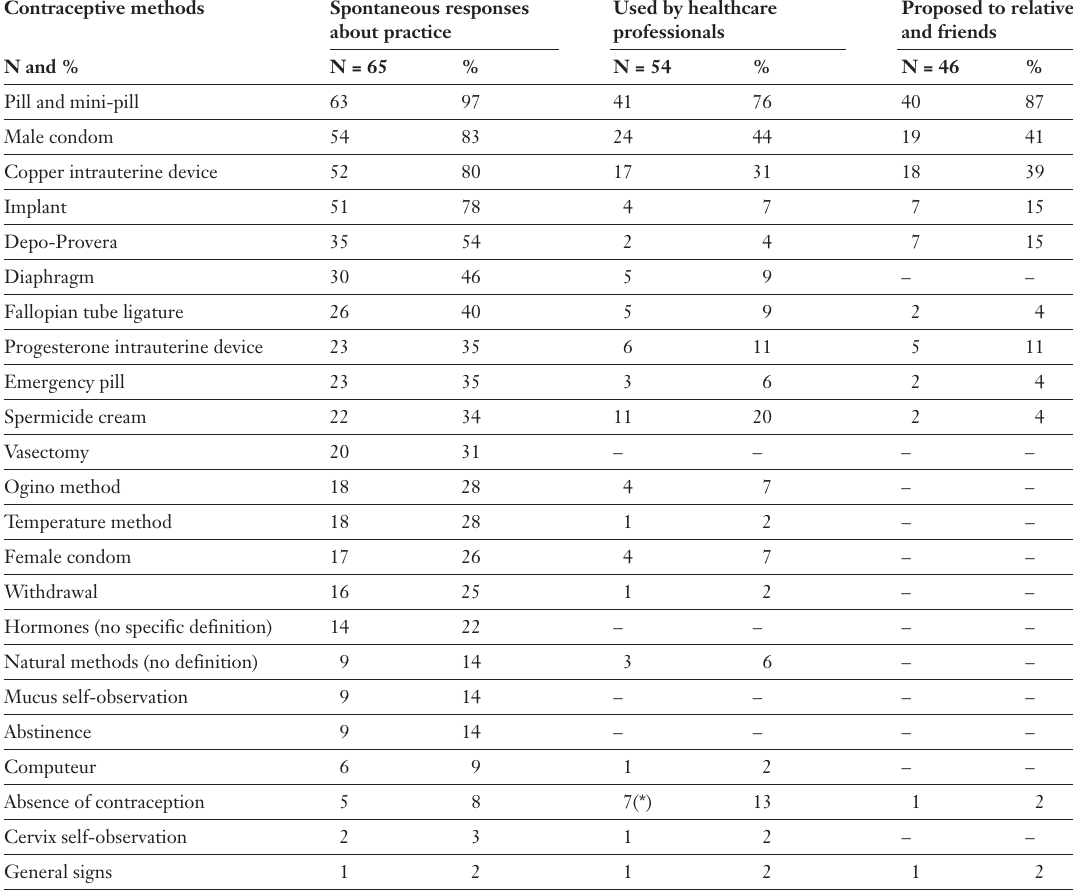
Comparison of con- traceptive methods mentioned in sponta- neous responses about their profes- sional practice, used by healthcare profes- sionals themselves, and proposed to their relatives and friends (categories are not mutually